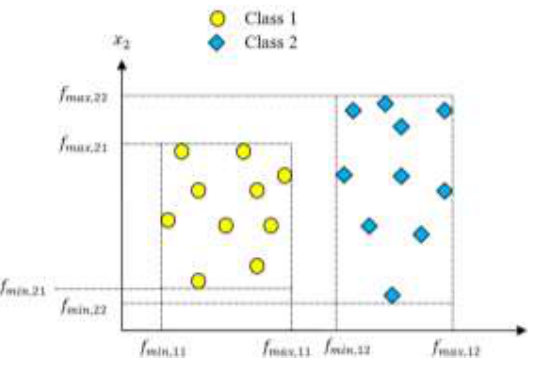
Figure 3. An example of determination of overlap between two